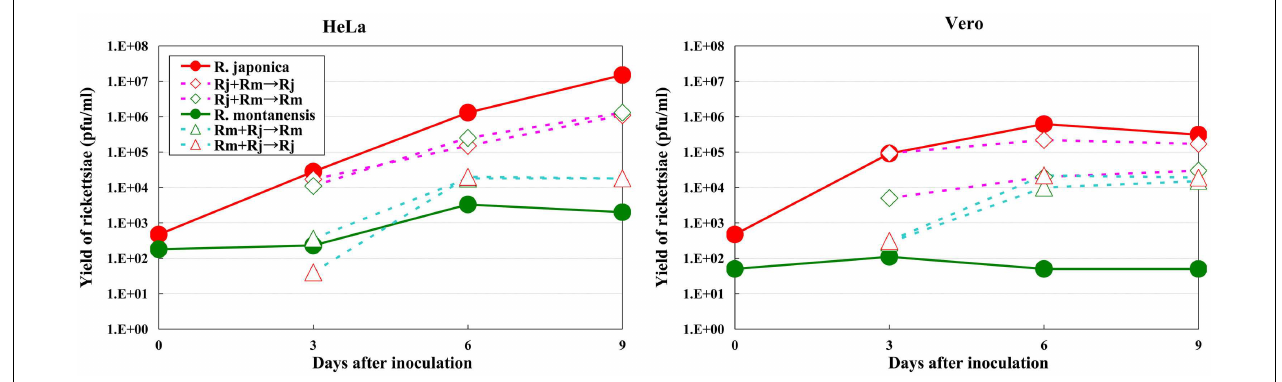
of infection, and the growth of each Rickettsia was monitored.The growth of non-pathogenic SFGR was restricted in mammalian cells.The superinfection of the infected cells with pathogenic SFGR induced an elevated yield of the non-pathogenic SFGR and the growth of the pathogenic